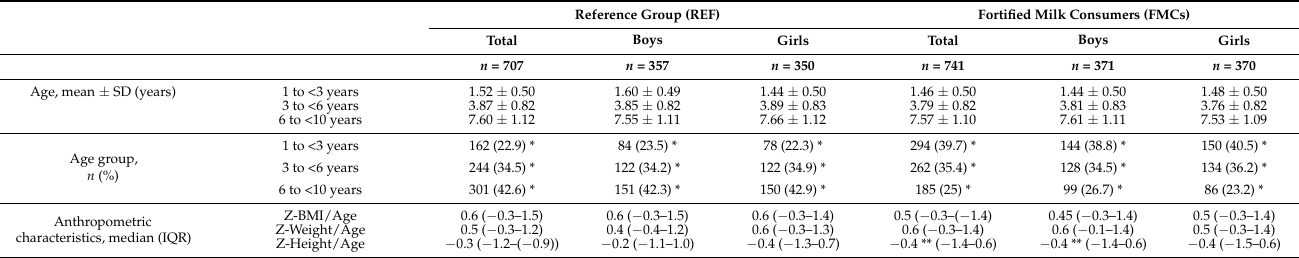
Table 1. Sociodemographic and anthropometric characteristics by age group and sex of two subpop- ulations, differing based on milk